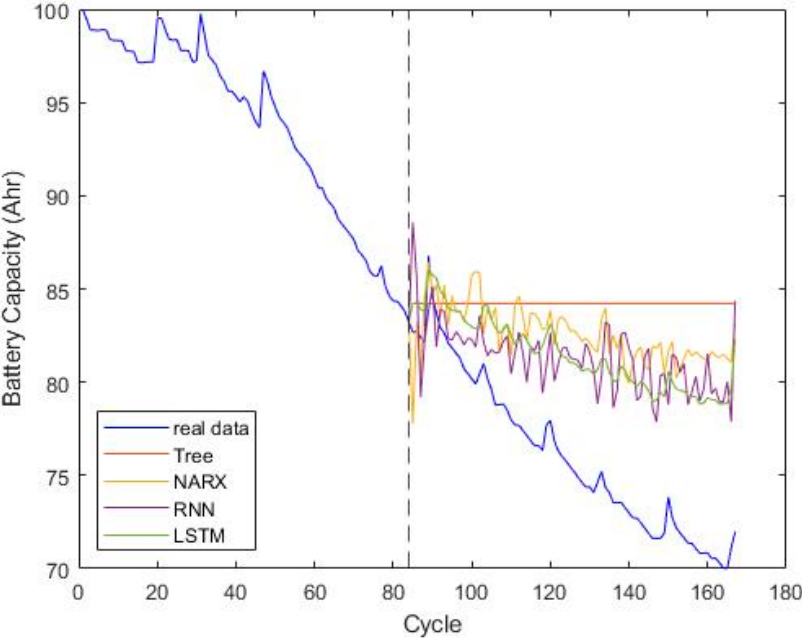
Figure 10. Prediction trends with different learning models (50% data for model training).